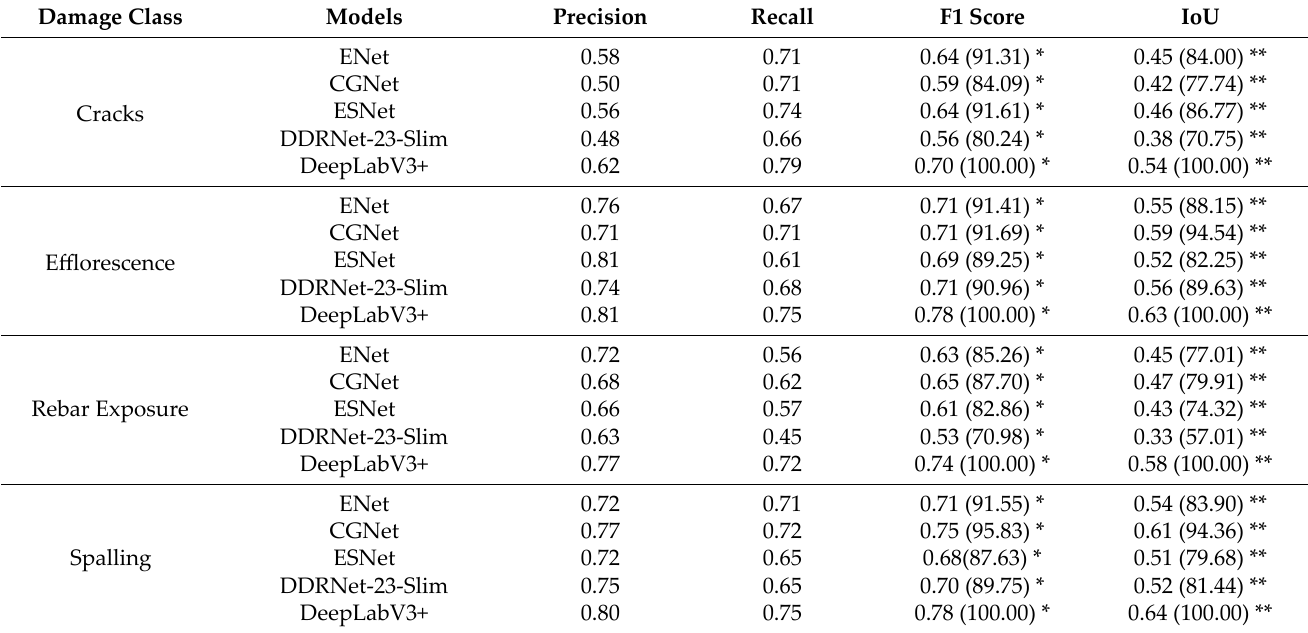
Table 1. Evaluation results of all trained models corresponding to each damage